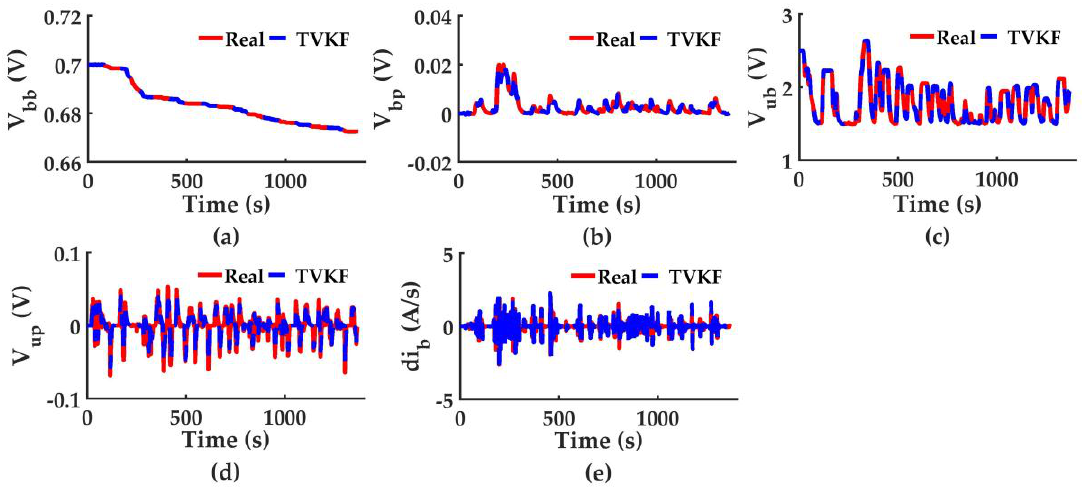
Figure 6. States values estimated by TVKF of AMPC. ( a ) V bb estimation; ( b ) V bp estimation; ( c ) V ub estimation; ( d ) V up estimation; ( e ) i b estimation. Table 5. Average states estimation errors of SSKF and TVKF.